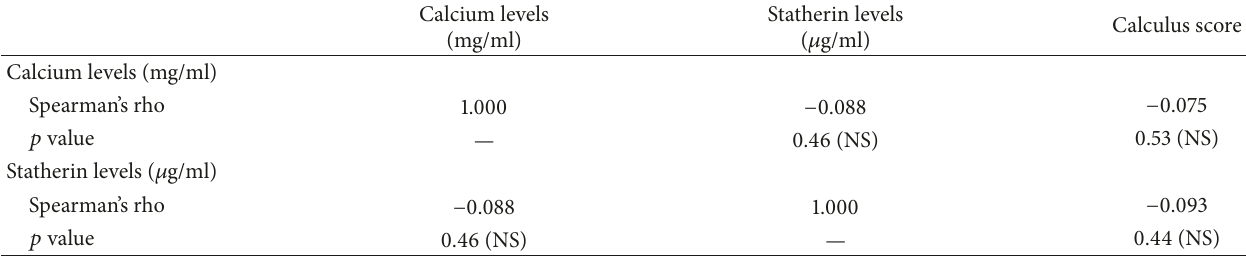
Table 1: Spearman’s correlation between salivary statherin level, salivary calcium level, and calculus score.